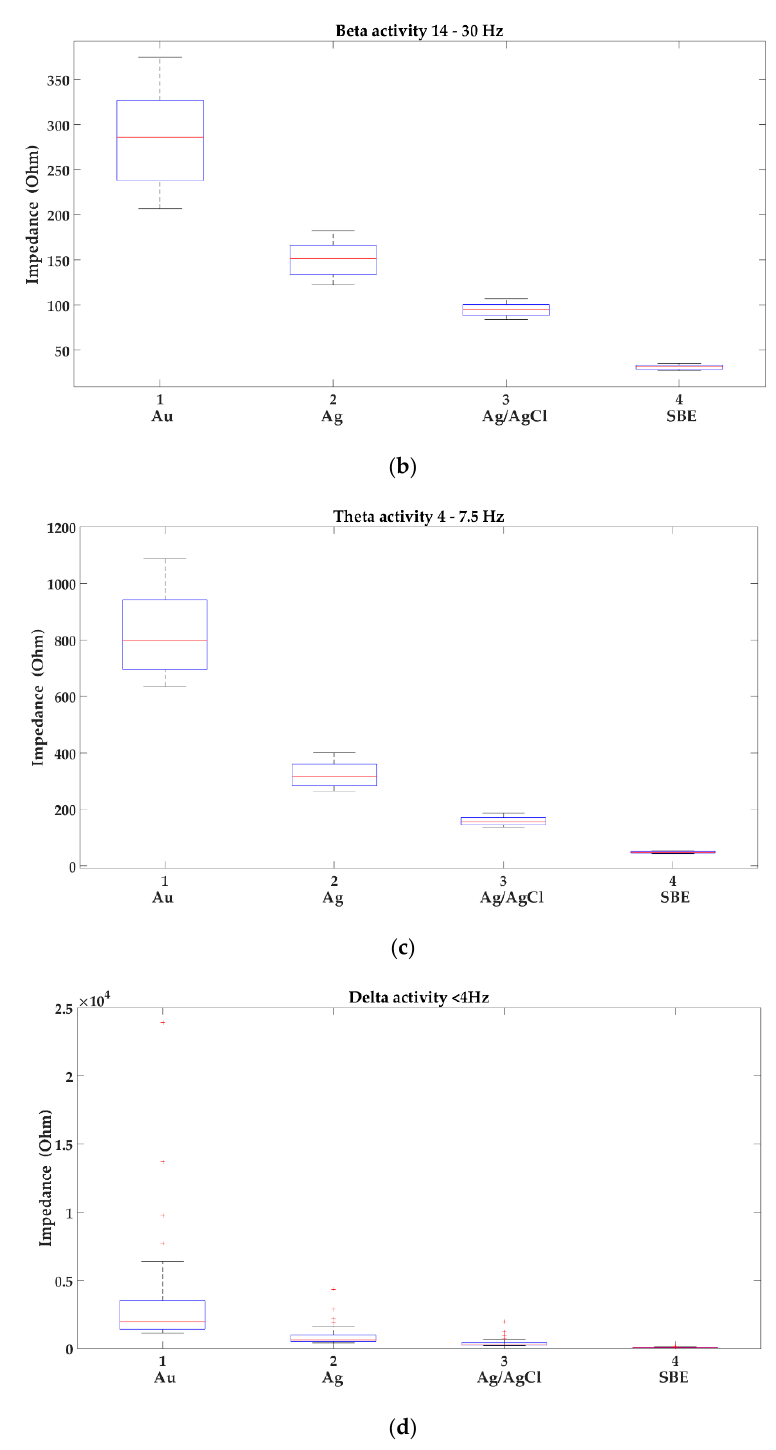
Figure 3. Analysis of the variability of impedance of new electrodes in the following brain activities: ( a ) alpha 8–13 Hz; ( b ) beta 14–30 Hz; ( c ) theta 4–7.5 Hz; ( d ) delta 0.1–3.5 Hz; where: 1-gold (Au), 2-silver (Ag), 3-silver/silver chloride (Ag/AgCl) and 4-sintered bridge electrodes (SBE). Within the box, a horizontal red line means the median value of the data set, whereas the bottom and top blue lines of the box indicate the 25th and 75th percentiles, the whiskers present min and max, and the outliers are marked with the ‘+’ symbol.